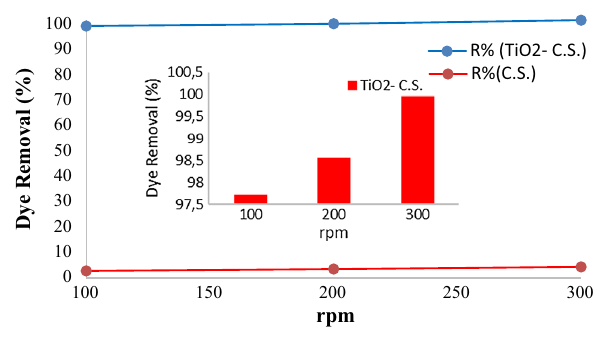
Fig. 8 Effect of stirring rate on the photocatalytic removal rate of RB5 azo dye (pH 3.0, 25 °C, 30 s)